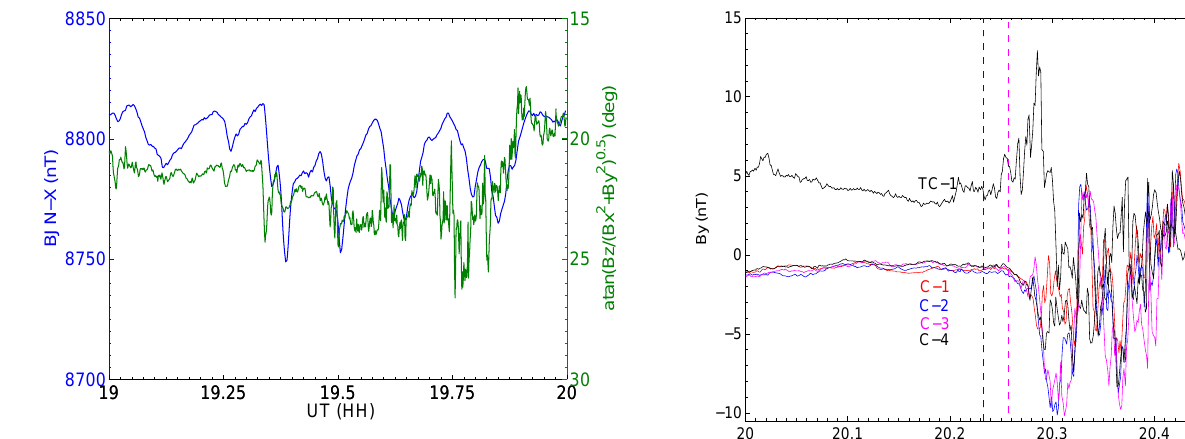
Fig. 5. X component variations observed at BJN, as well as eleva- tion angle changes of the magnetic field at TC-1. Such signatures are typical for a pseudo-breakup. In space, features are observed about 40s earlier than on the ground.